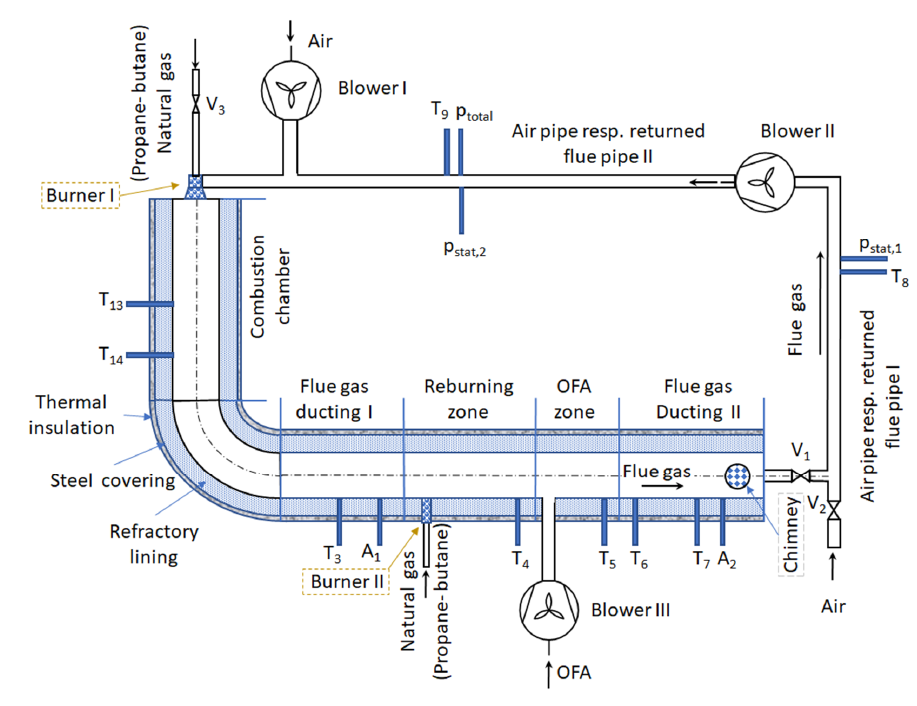
Figure 1. Experimental setup scheme with main equipment dimensions listed in mm. Legend: T—thermocouple, A—analyzer, V—throttle valve, p stat —static pressure, p total —total pressure, OFA— overfire air.